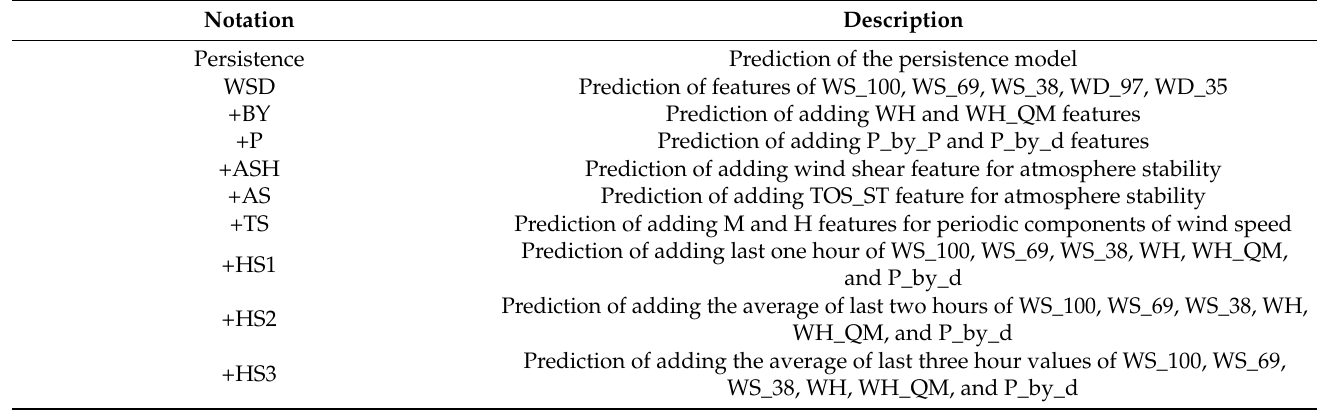
Table 2. The feature groups used in different models. The features were added sequentially according to the feature’s importance.